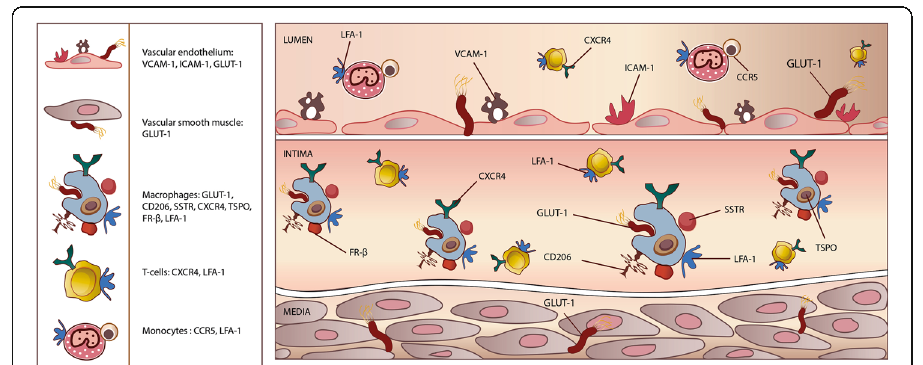
Fig. 2 An illustration of the vessel wall and lumen showing current and potential targets on the vessel wall and inflammatory cells that can be explored for radionuclide imaging of vessel wall inflammation among people living with HIV